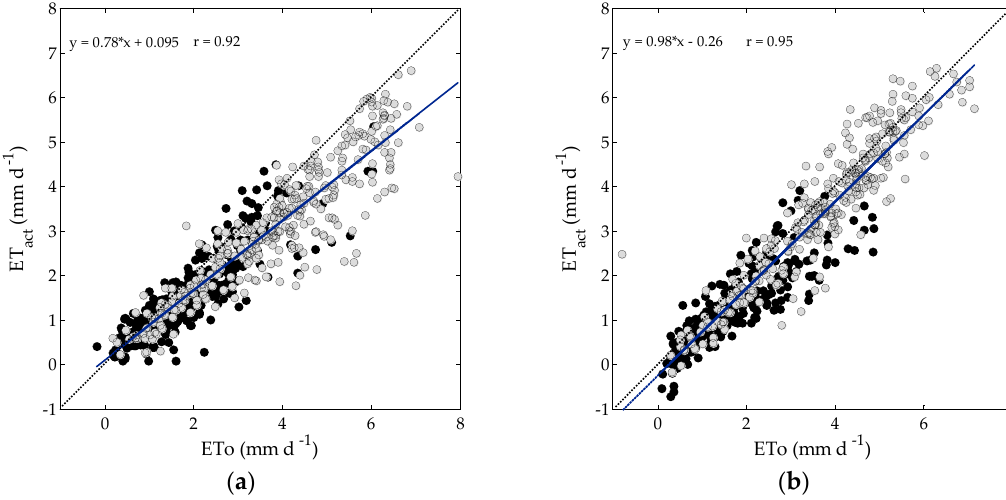
Figure 8 . Scatterplots of daily ET act and ET o for ( a ) SMA and ( b ) PAS. The black dots are for the AW period and the gray dots are for the SS period. The solid blue line represents the linear fit of all data. For reference, the 1:1 line is also shown (dashed black line).